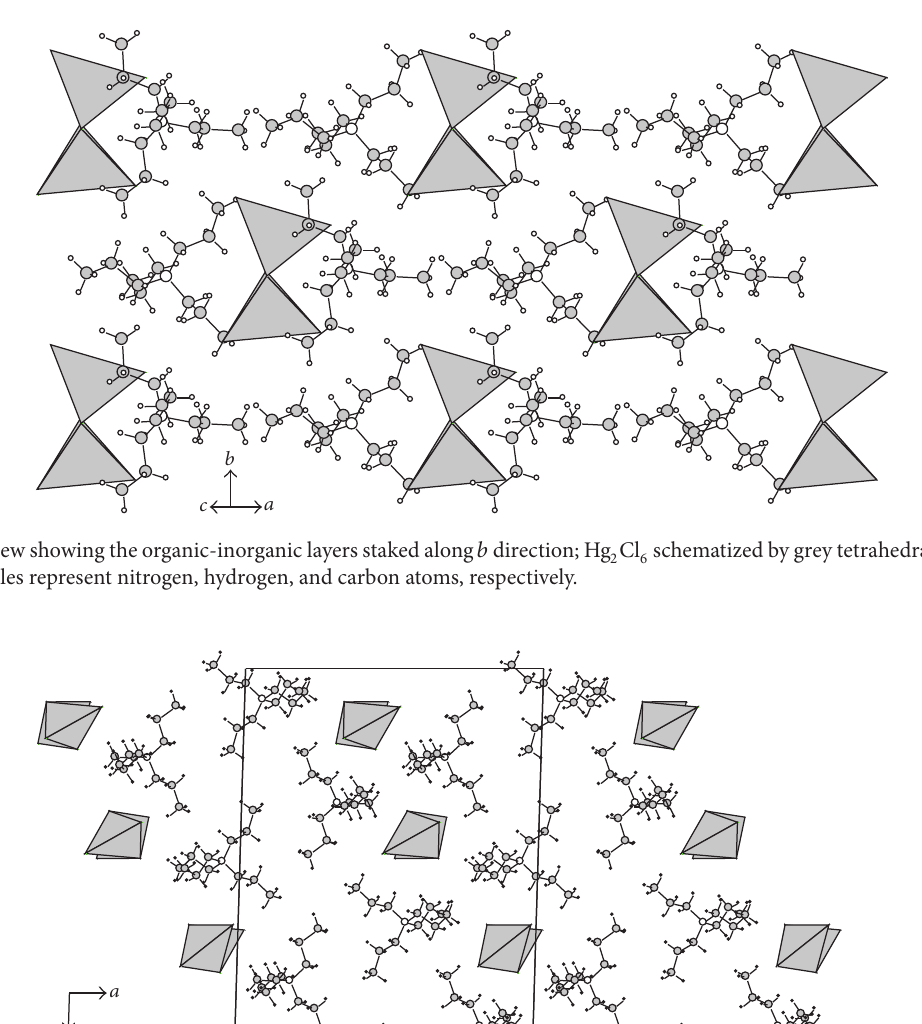
of the asymmetric unit. %